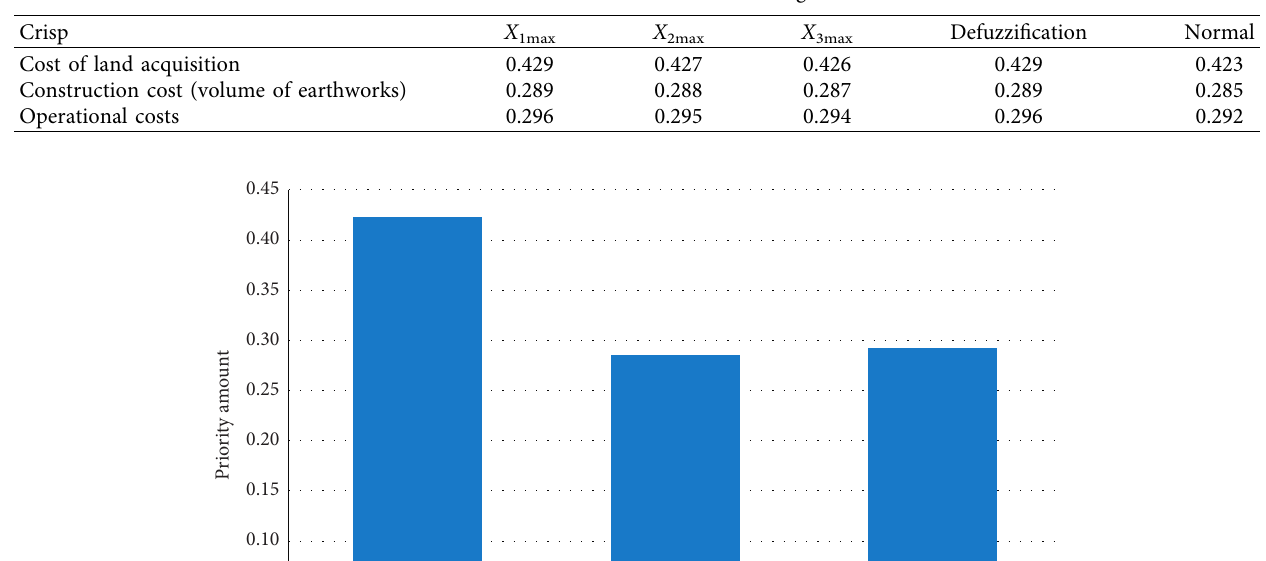
Table 8: Defuzzification and determination of the definite weight of economic subcriteria.